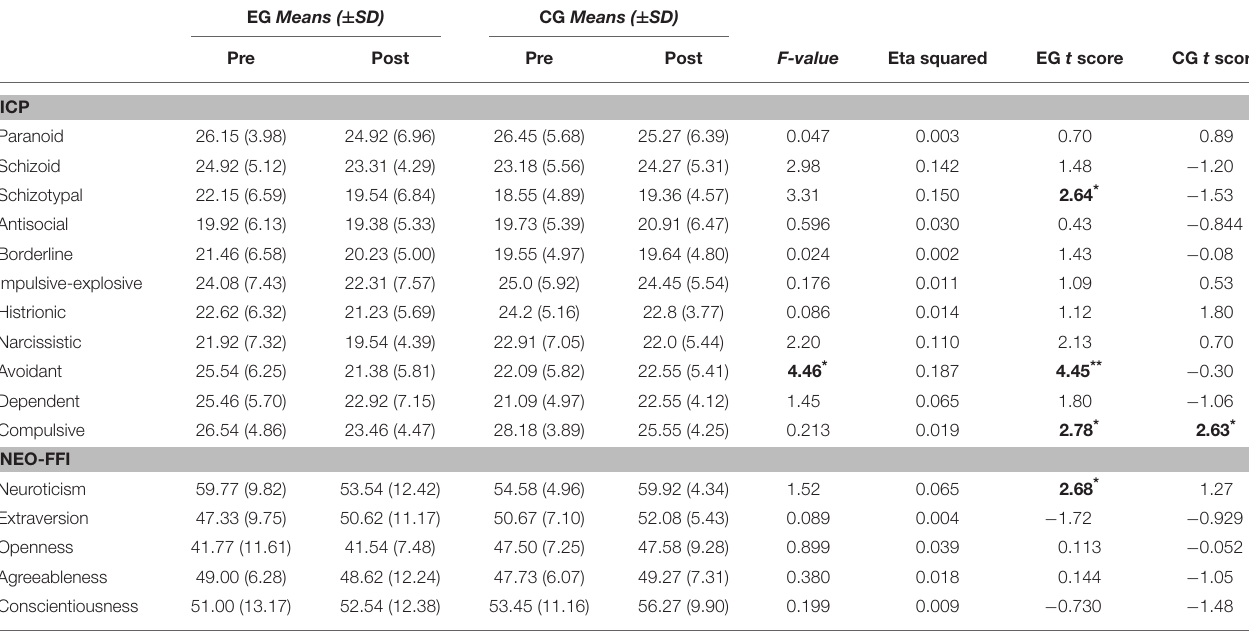
TABLE 2 | Differences in ICP and NEO-FFI scores between the groups (Means, standard deviations, F -statistics and effect sizes for ANCOVAs, p -values for paired sample t -tests).